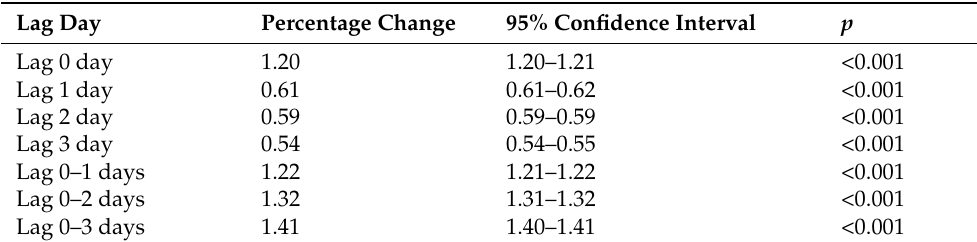
Table 3. Percentage change in the number of outpatient visits for knee osteoarthritis corresponding to a 10- µ g/m 3 increase in PM 2.5 concentration for various lag